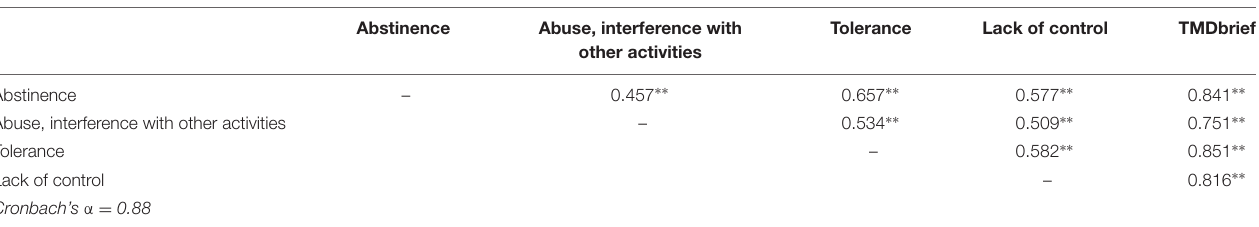
TABLE 2 | Factor correlation matrix.